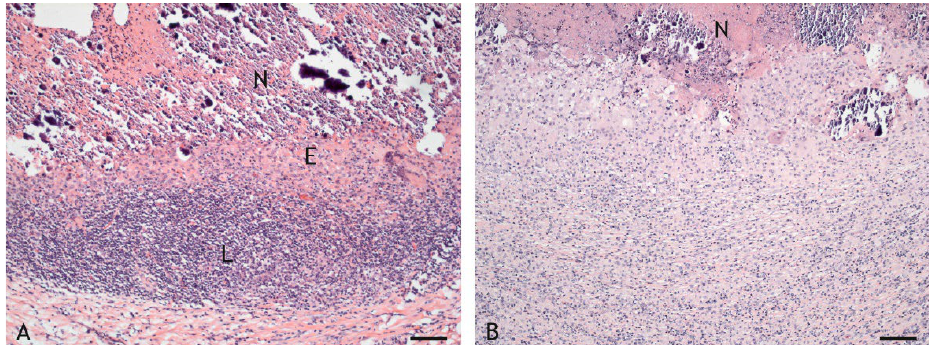
Figure 8. Differences in width and thickness of inflammatory infiltrate. ( A ). BCG-induced granuloma, goat 15: distinct area of epithelioid cells (E) adjacent to the necrosis (N) followed by lymphocytes (L). ( B ). VPM1002-induced granuloma, goat 1: epithelioid cells and lymphocytes are mixed throughout the infiltrate adjacent to the necrosis (N). HE stain. Scale bars = 100 µm.